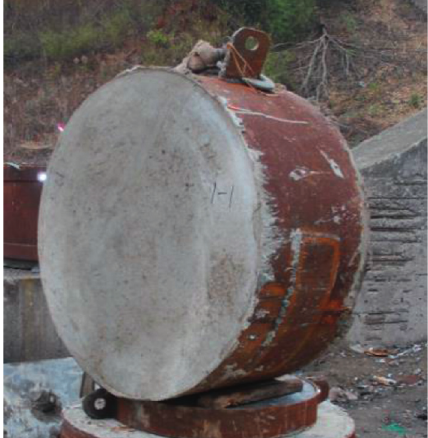
Figure 3: Experimental concrete